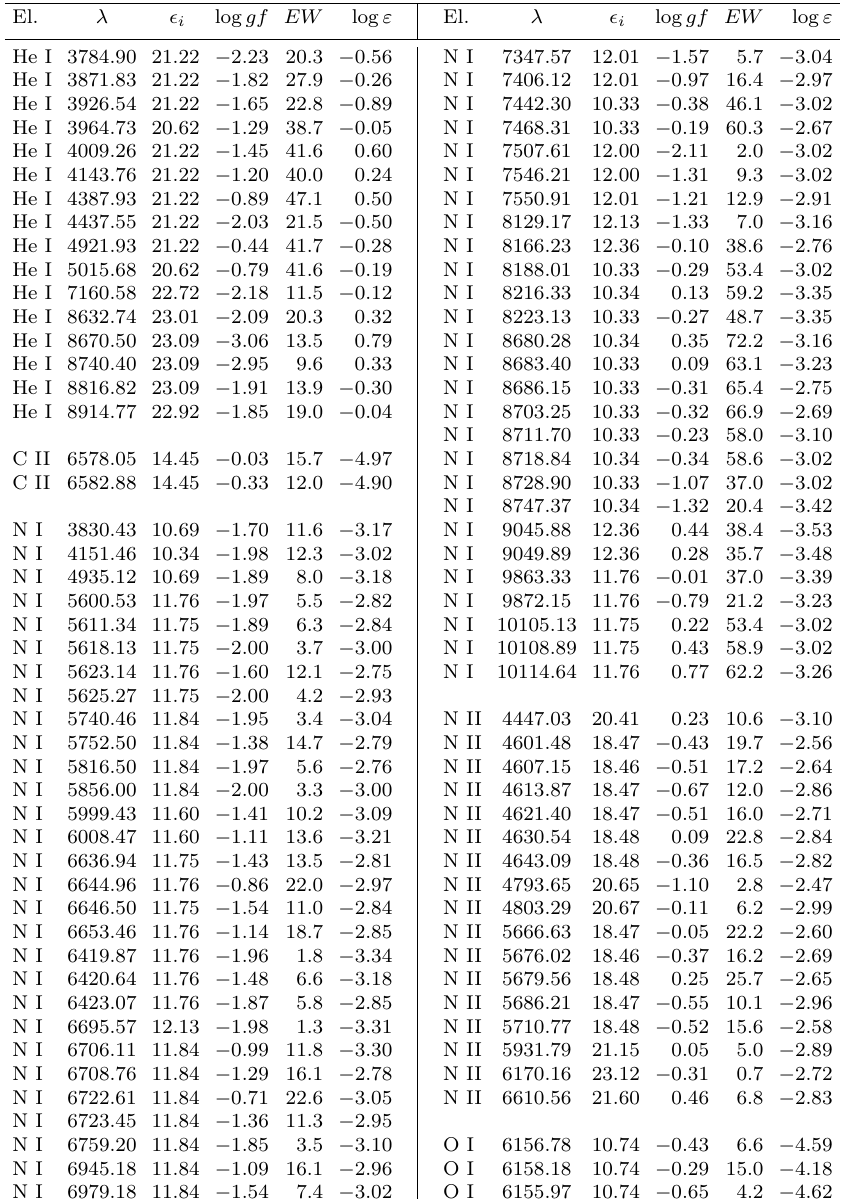
Table 7. Atomic data (wavelengths [(cid:23)A], lower level excitation potentials ϵ i [eV], oscilla- tor strengths log gf ), equivalent widths [pm] and abundances calculated with the model parameters T eff = 12000 K, log g = 2 . 5 for υ